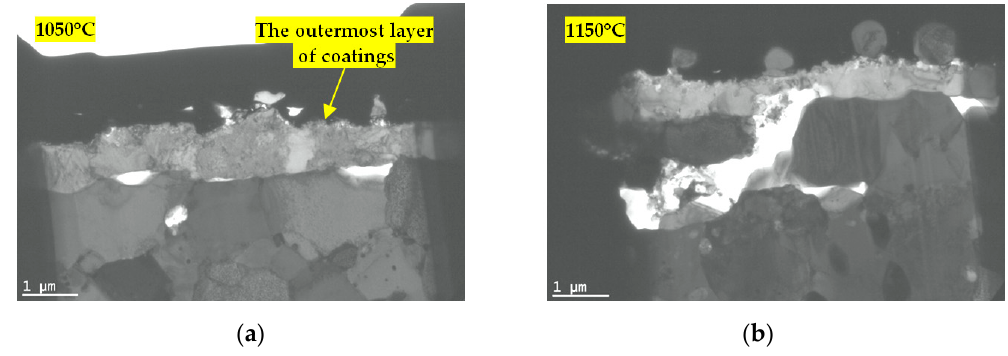
Figure 5. TEM images of the cross-section of the surface coatings on the blades exposed to: ( a ) 1050 °C; ( b ) 1150 °C.